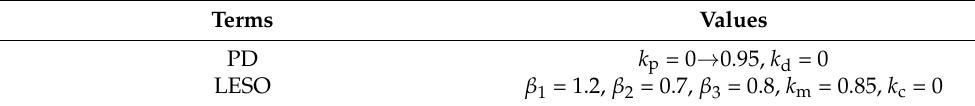
Table 1. Initial parameters in step 1.